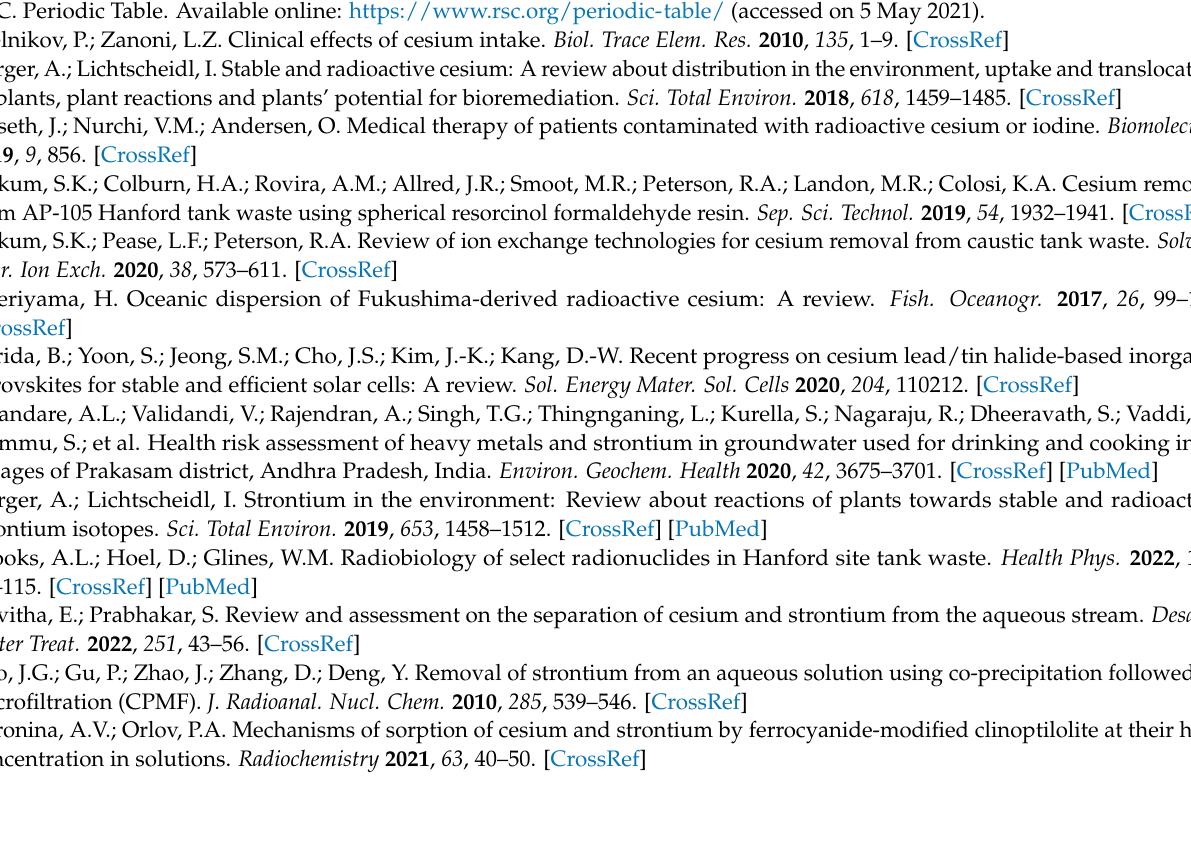
Figure A22. SEM observation (left panel) and semi-quantitative EDX analysis (right panels) of ALG-PEI ( a ) and APO-PEI ( b ) after the treatment of seawater.